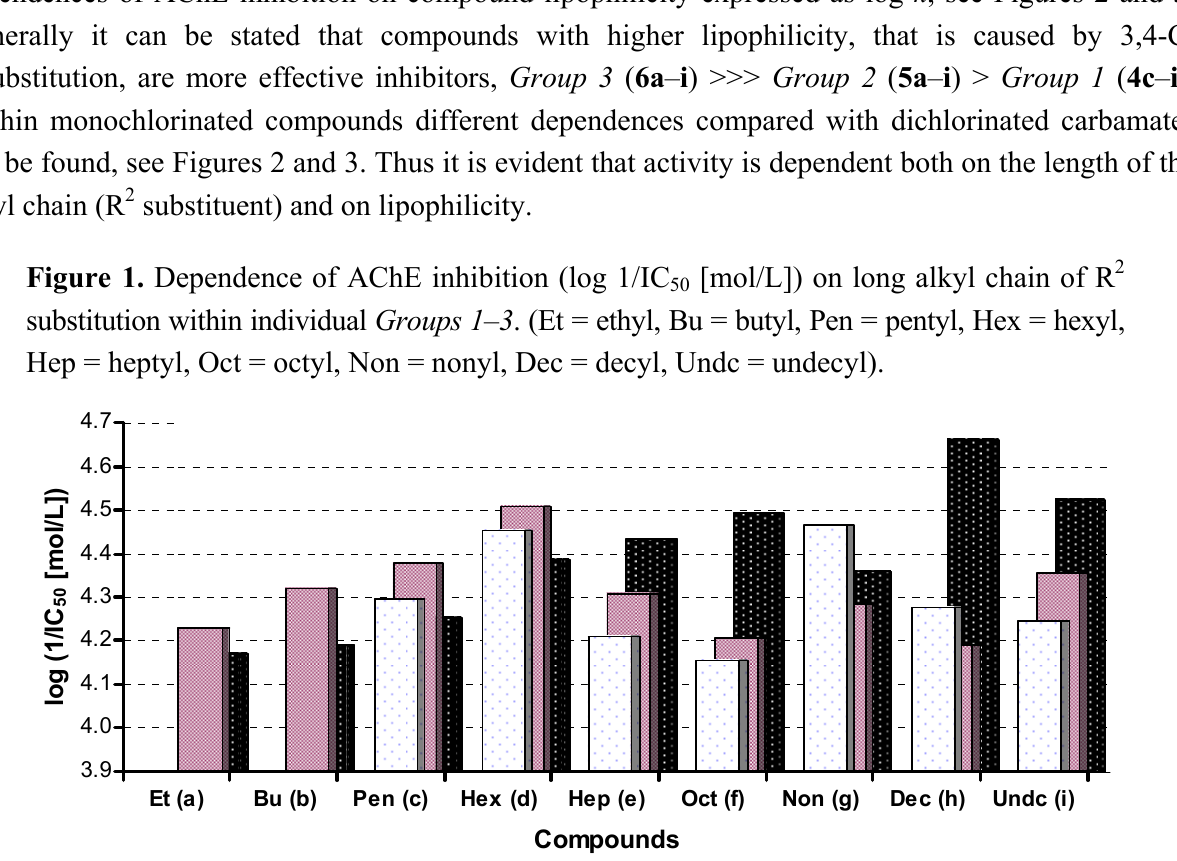
[mol/L]) on long alkyl chain of R 2 50